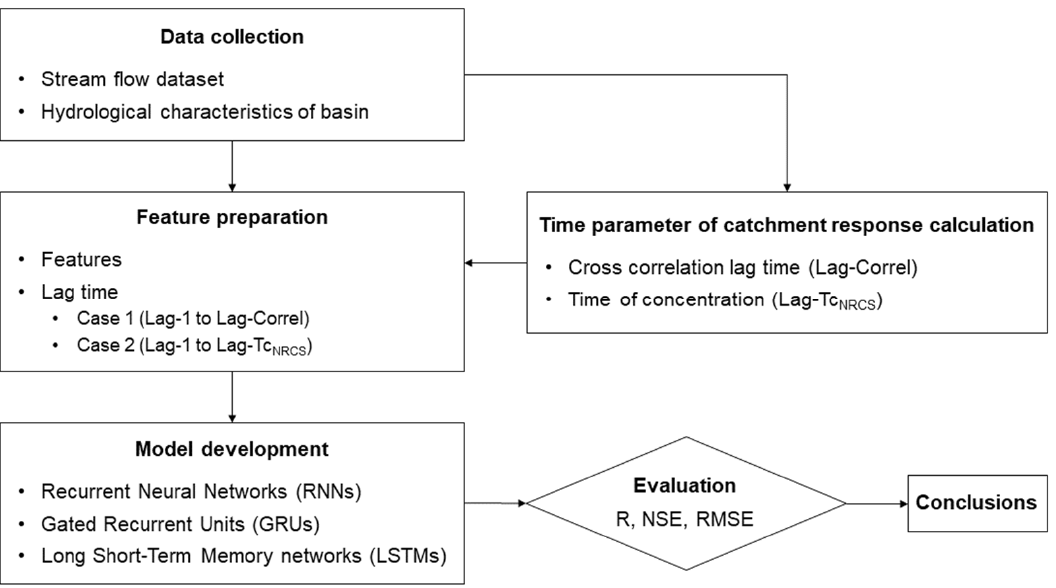
Figure 2. A flow process chart.